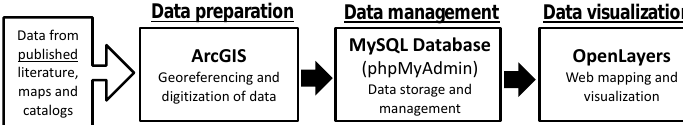
Figure 4. Flowchart of the process for the CAFD development.